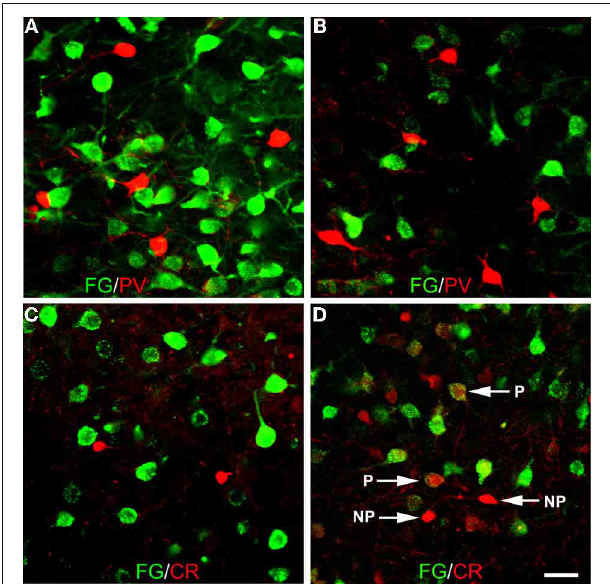
FIGURE 10 | Photomicrographs of immunofluorescence preparations dual-labeled for FG/PV or FG/CR. (A) Dual-localization of FG (green) and PV (red) in the anterior basolateral nucleus. Note lack of colocalization. (B) Dual-localization of FG (green) and PV (red) in the posterior basomedial nucleus. Note lack of colocalization. (C) Dual-localization of FG (green) and CR (red) in the anterior basolateral nucleus. Note lack of colocalization. (D) Dual-localization of FG (green) and CR (red) in the posterior basomedial nucleus. Note lack of colocalization in small non-pyramidal neurons exhibiting robust CR-ir (NP), but existence of colocalization in larger pyramidal neurons exhibiting light CR-ir (P). Scale bar in D = 40 µ m (also applies to A , B , and C